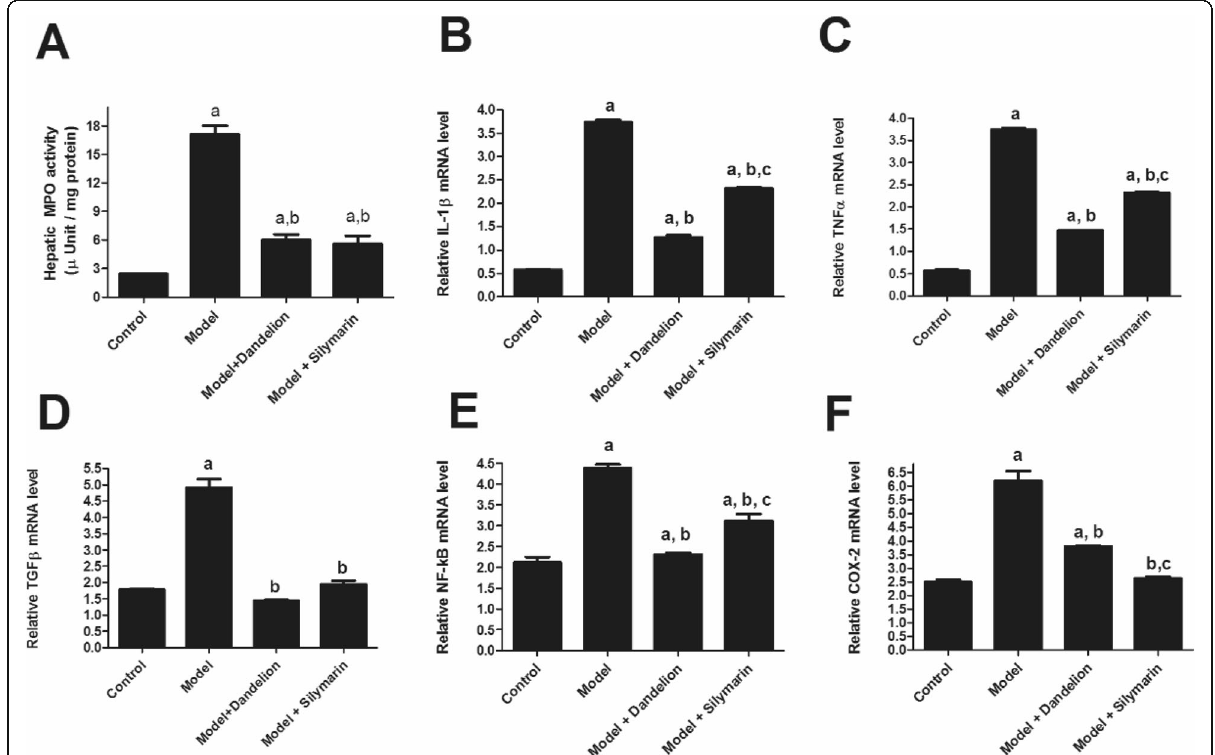
Fig. 6 Effects of dandelion and silymarin on inflammatory markers. a MPO activity ( n = 6 per group) and mRNA expression of b IL-1 β , c TNF- α , d TGF β , e NF-kB, and f COX-2 in liver tissues ( n = 3 per group). Results of mRNA expression were normalized to GAPDH mRNA. Data are presented as means ± SEM. a P < 0.05 vs. control group. b P < 0.05 vs. CCL4 group. c P < 0.05 vs. dandelion